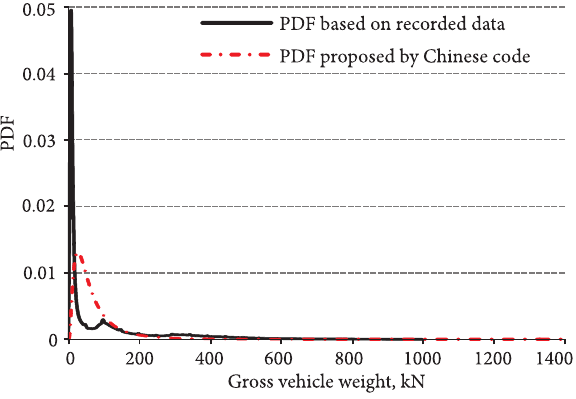
Fig. 5. PDF comparison of gross vehicle weight